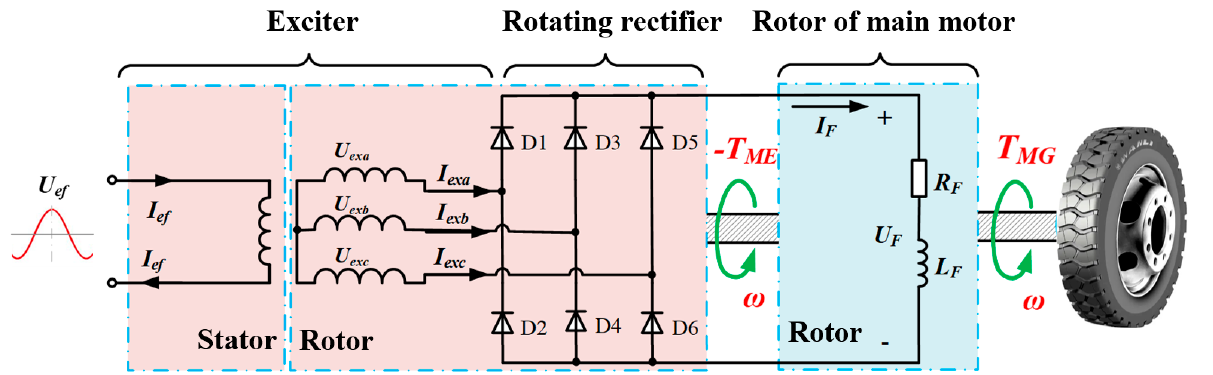
Figure 7. Equivalent circuit of single-phase AC excitation.